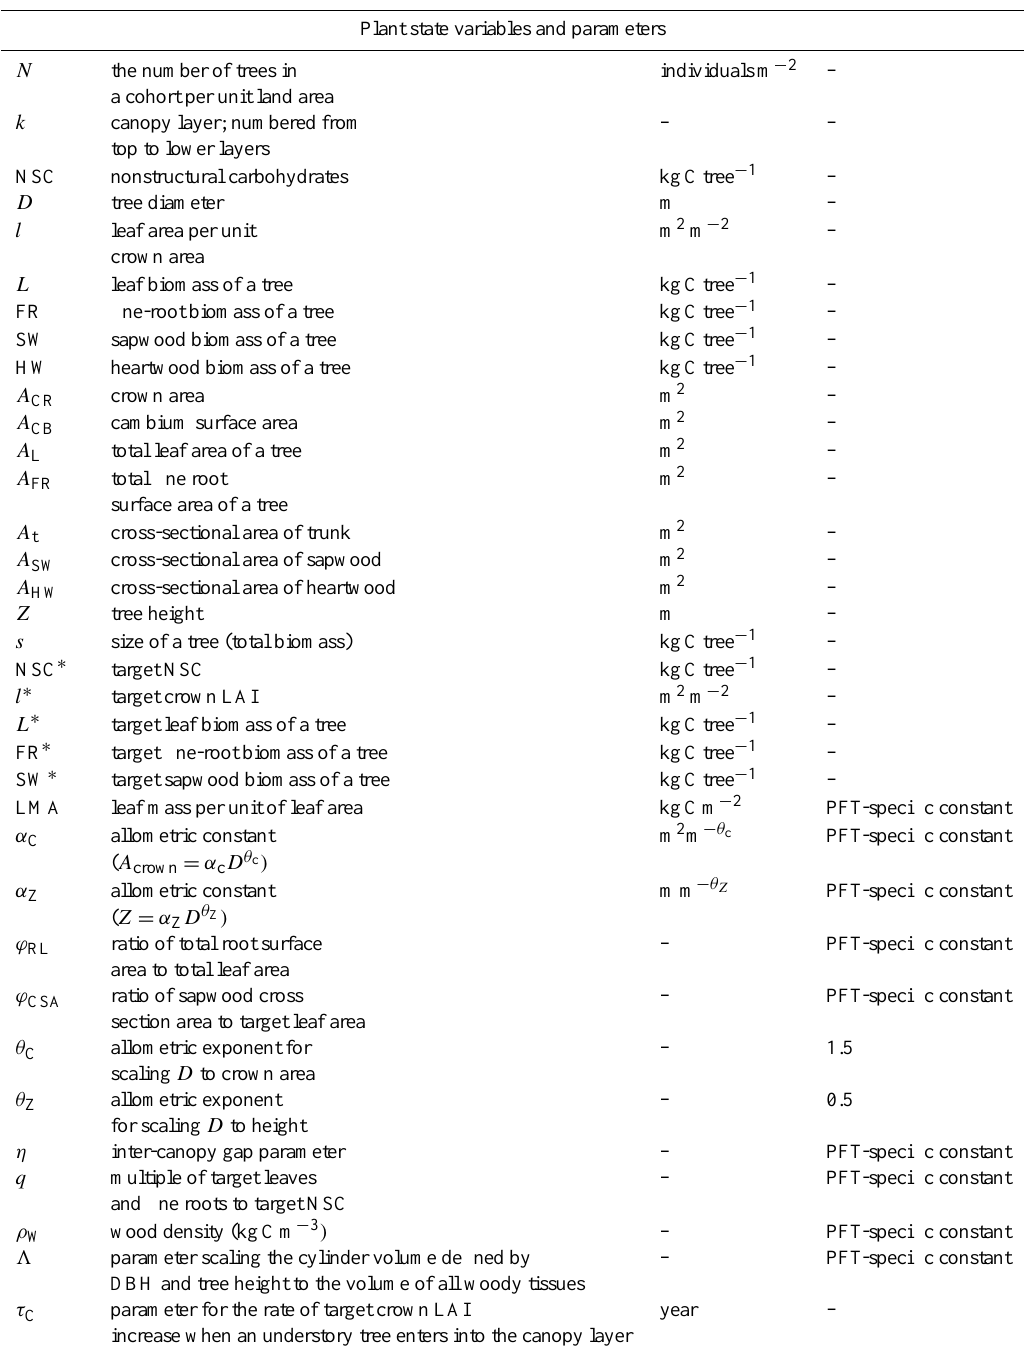
Table C1. Plant growth, respiration, and vegetation